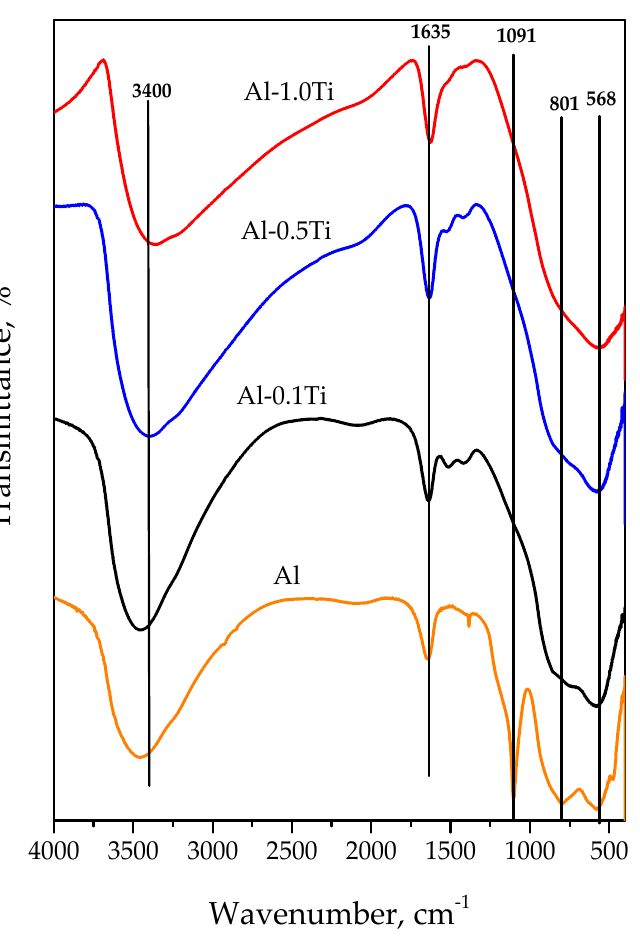
Figure 6. FTIR spectra of the Al-Ti binary oxide systems.